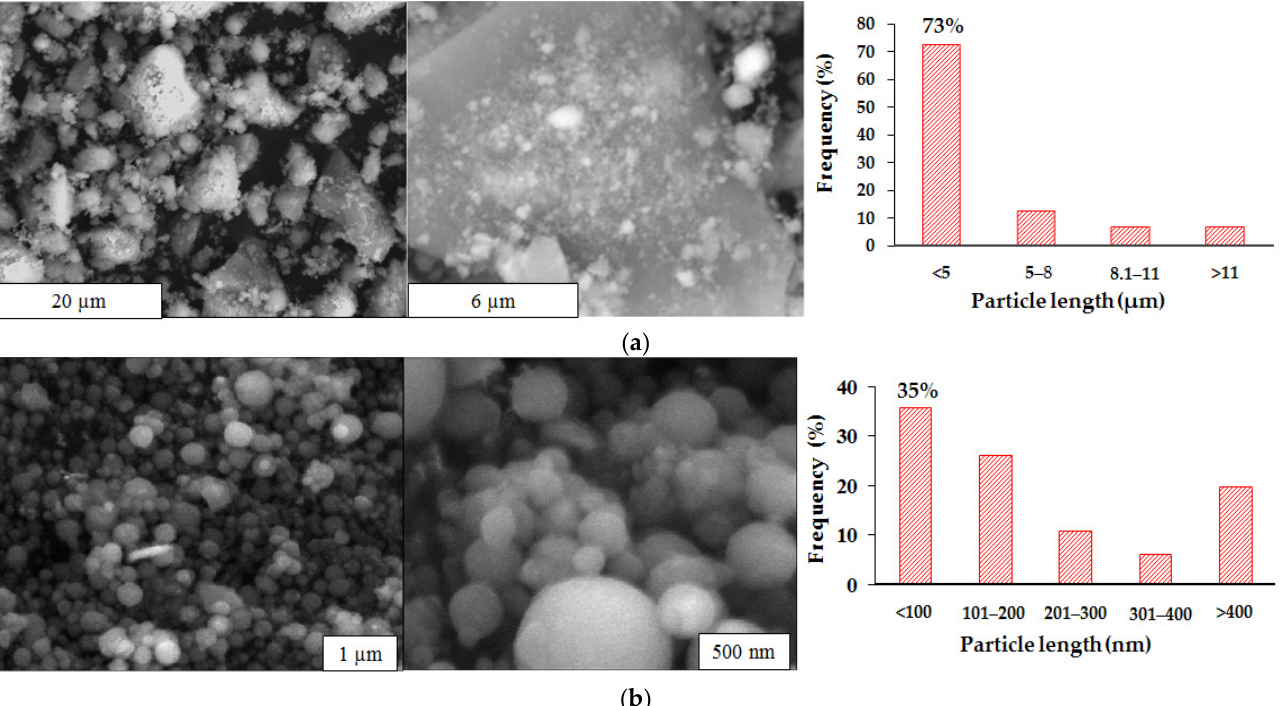
Figure 6. Histograms and micrographs obtained by SEM for the inorganic phases: ( a ) red mud (n = 70); ( b ) ferrosilicomanganese fines (n = 144).